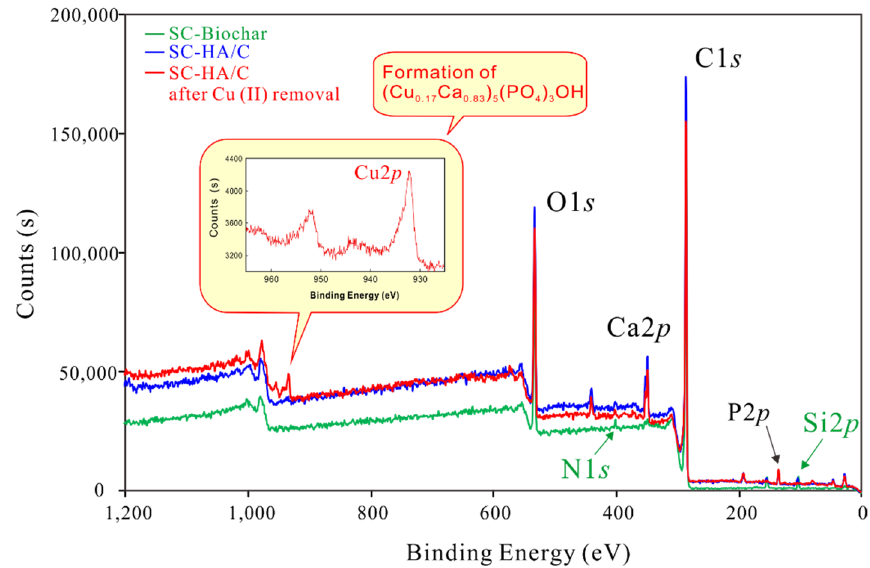
Figure 5. XPS spectra of the SC–HA/C composite before and after Cu (II) removal.